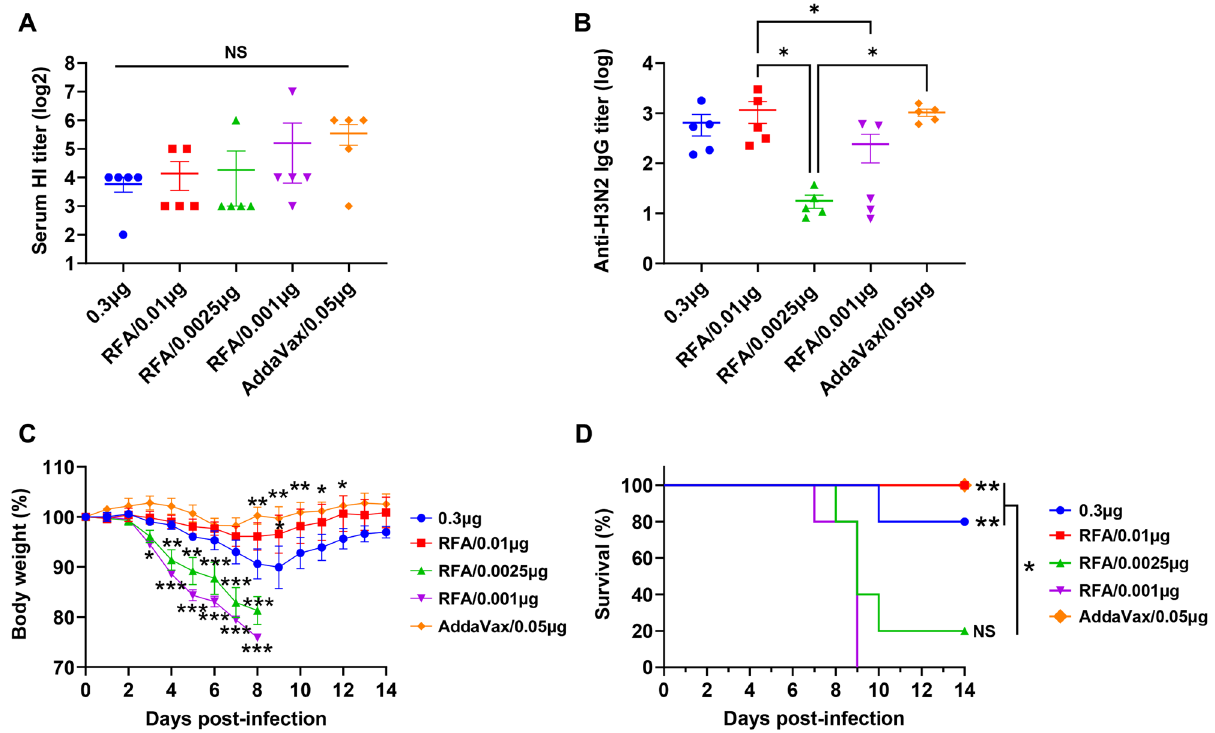
Figure 4. Dose-sparing effects of RFA in vaccine dose range (0.01–0.001 µg). BALB/c mice were intradermally injected with 0.3 µg H3N2 vaccine or subjected to RF treatment followed by ID injection of H3N2 vaccine of further reducing doses (0.01–0.001 µg). Serum HI ( A ) and IgG titers ( B ) were measured three weeks later. Mice were challenged with 50 × LD50 of H3N2 viruses four weeks after immunization. Body weight change ( C ) and survival ( D ) were monitored daily for 14 days. n = 5. One-way ANOVA with Dunn’s multiple comparison test was used to compare differences among groups in ( A ) and ( B ). Two-way ANOVA with Dunnett’s multiple comparison test was used to compare differences between vaccine alone and other groups in ( C ). Log-rank test with Bonferroni correction was used to compare differences of survival between RFA/0.001µg and other groups except otherwise specified in ( D ). *p < 0.05; **p < 0.01; ***p < 0.001. NS not